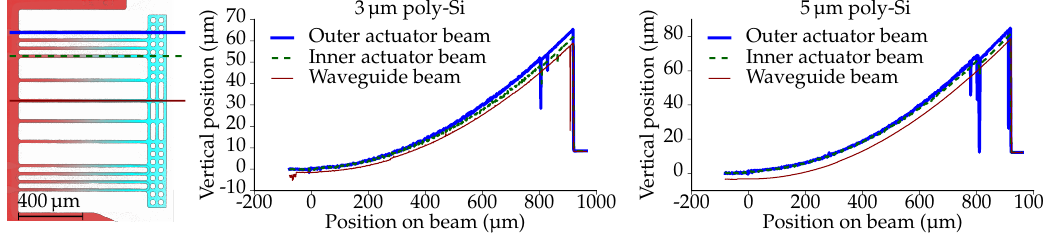
Figure 10. ( left ) Top view of the measured suspended structures, indicating the locations of the three profiles. ( middle , right ) The post-release deflection (without actuation) measured over the length of three beams.